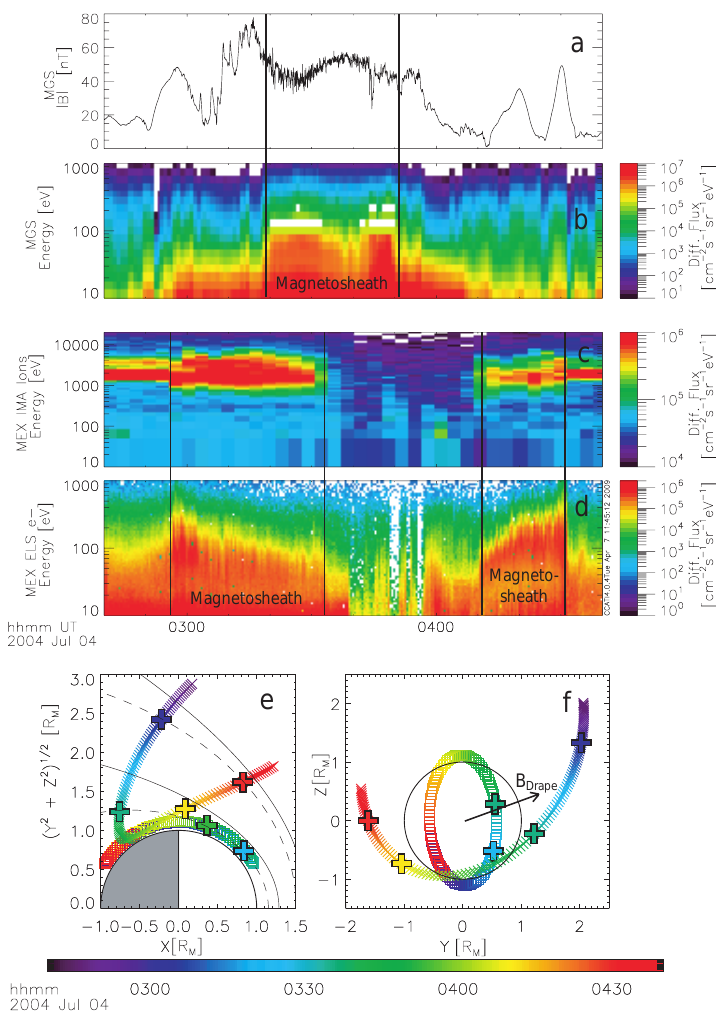
Fig. 4. As for Fig. 3 except for Case